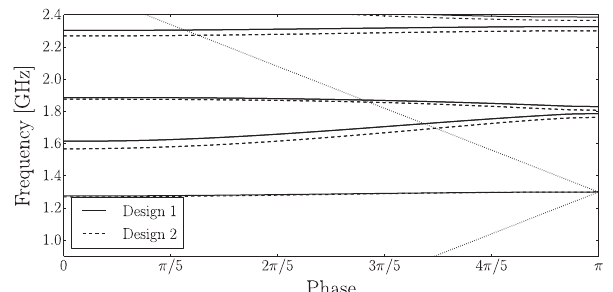
FIG. 7. Dispersion diagram for the two mid cell designs. A clear separation between the passbands can be seen with the exception of the first passband in which the operating mode is shared. For a symmetric structure the passbands would be identical. The dotted line shows the speed of light curve.